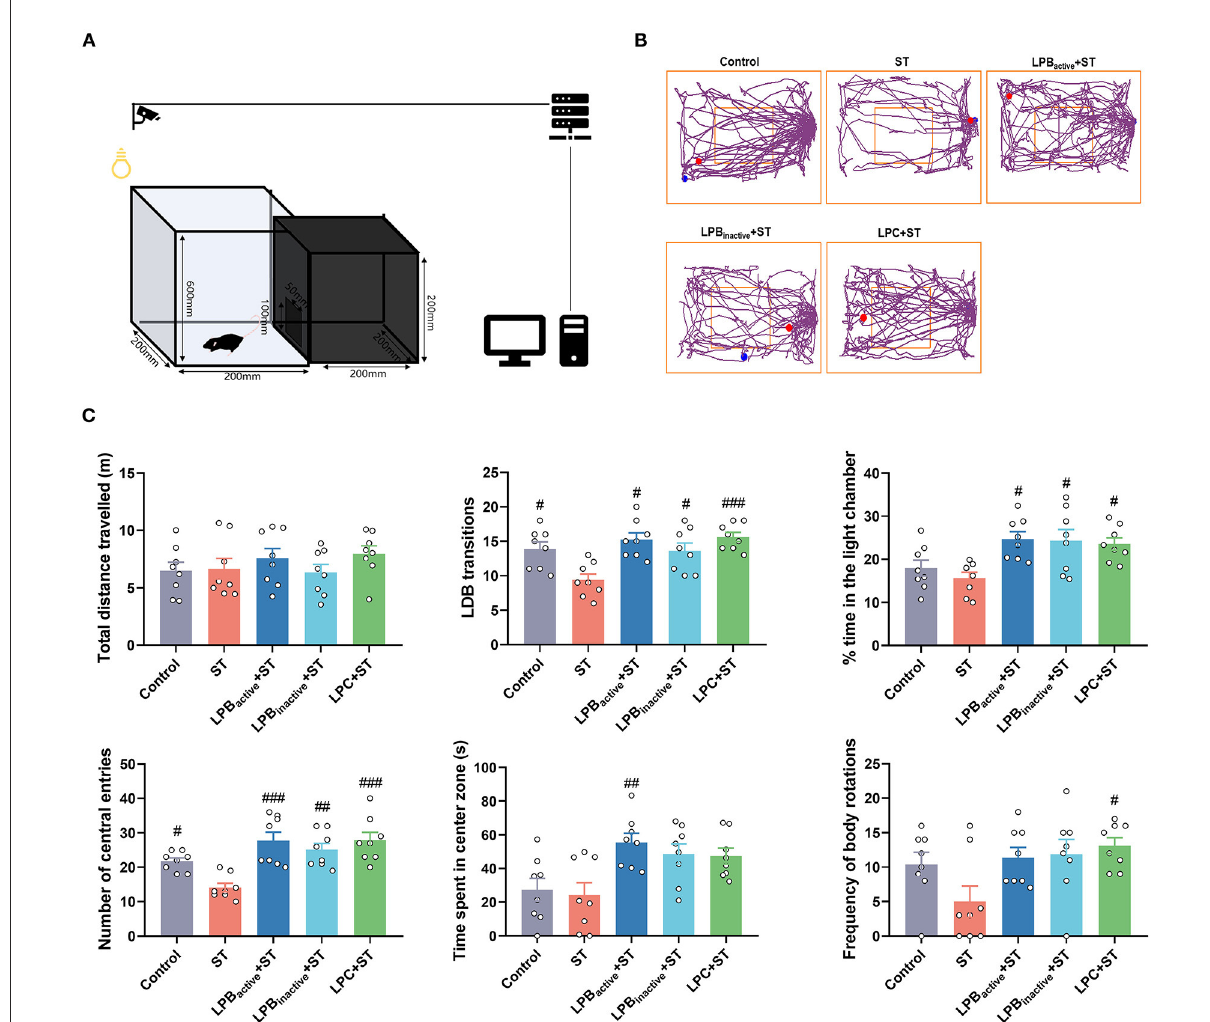
FIGURE5 The light–dark box (LDB) test representing anxiety-like behaviors. (A) A cartoon of the apparatus for LDB test is shown. (B) Characteristic tracks of mice in the light box. The blue dot represents the start point and the red dot represents the end point of the mouse activity. (C) Main data of LDB test. Statistical analysis of the total distance, LDB transitions, time spent in the light chamber, and number of central entries, and time spent in center zone. The data shown as mean ± SEM were analyzed by one-way ANOVA and Tukey’s test ( N = 8 in each group). # Indicates the significance compared to ST group: # p < 0.05, ## p < 0.01, ### p <